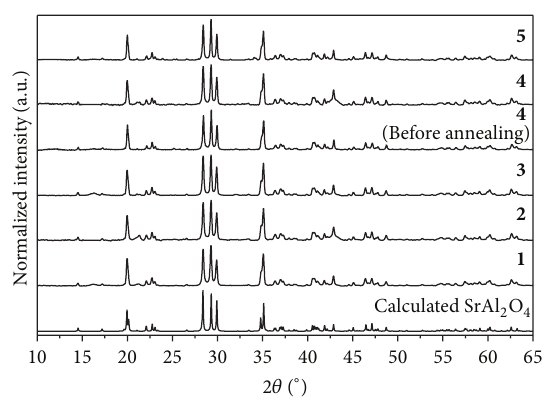
Figure 1: X-ray diffraction analysis of compounds 1–5 in compari- son to the calculated diffraction pattern for SrAl 2 O 4